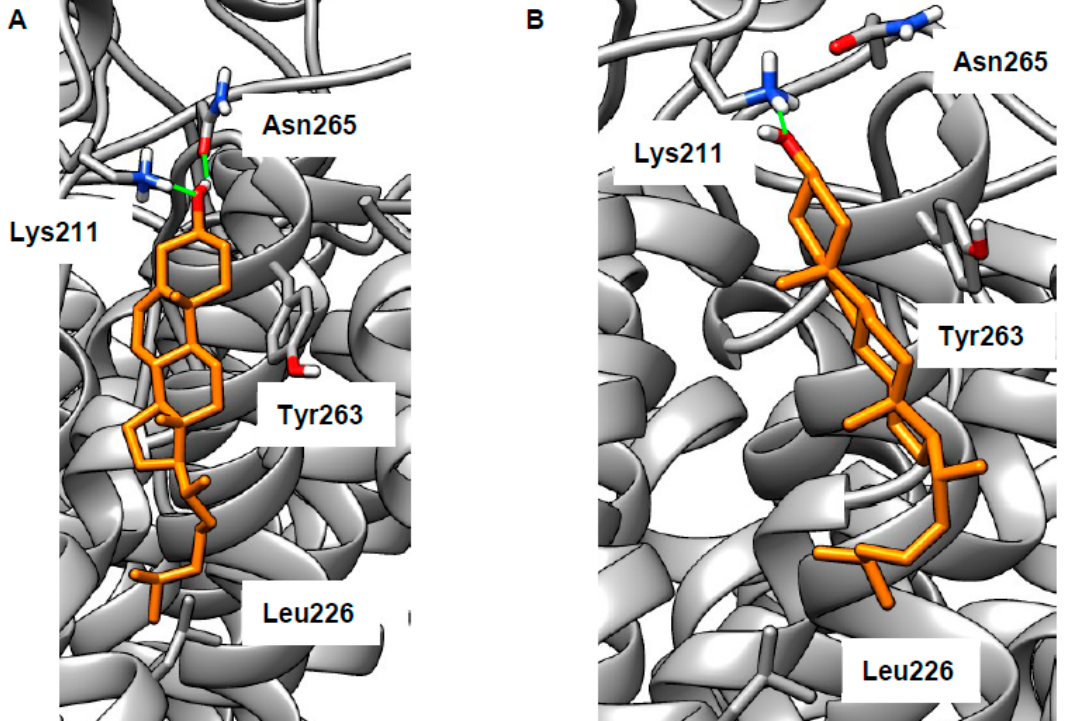
Figure 4. Sample cholesterol-binding poses at the putative binding site on the voltage sensor of big potassium channel (BK). Cholesterol (orange) is able to form H-bonds (green) with Lys211 ( A , B ) and Asn265 ( A ), a CH– π interaction with Tyr263 ( B ), and a hydrophobic interaction with Leu226 ( A , B ). The implications of cholesterol-induced BK dysfunction for NPCD are multiple (Figure 1).